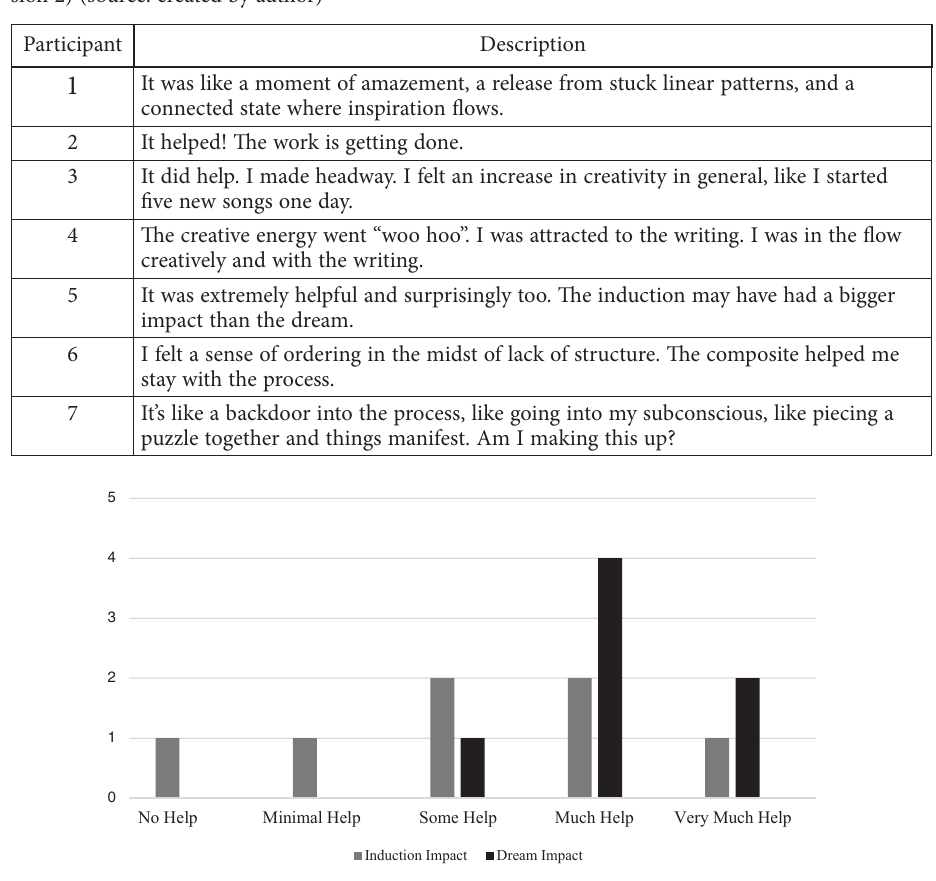
Figure 1. Number of participants by subject impact (source: created by